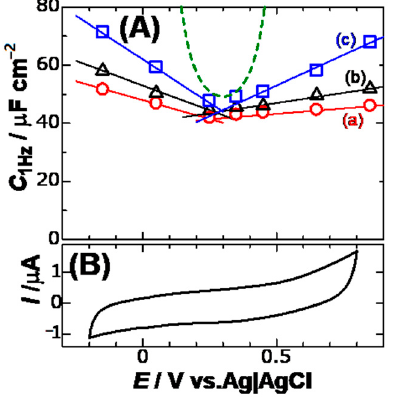
Figure 5. ( A ) Variations of C 1Hz with dc potentials ( E dc ) for c = (a) 2, (b) 3 and (b) 5 M, and ( B ) CV at the scan rate 0.05 V s − 1 in 3 M KCl solution. The dashed curve in ( A ) is by the GC theory for c = 5 M and ε r = and ε r = 78.